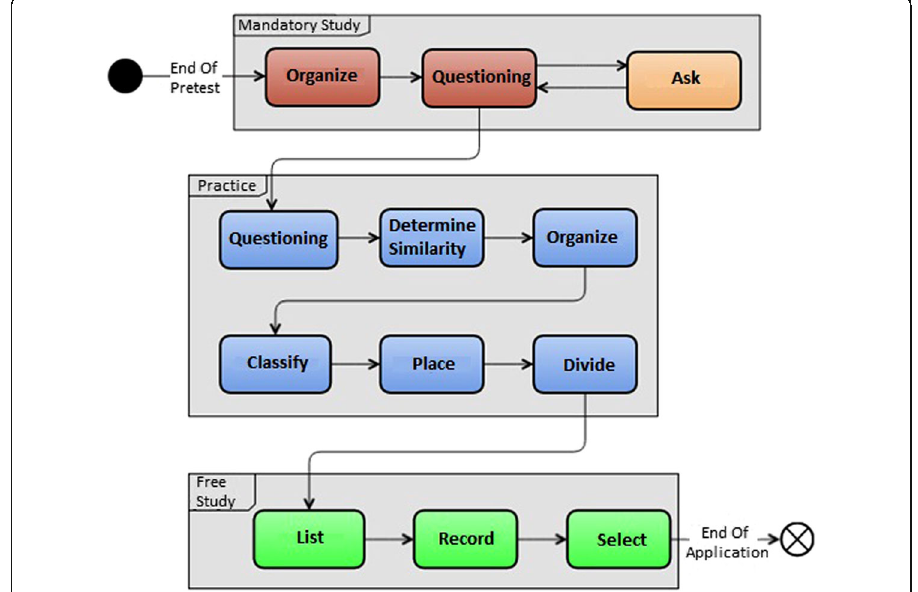
Fig. 11 A learner ’ s navigation path with faulty answers in